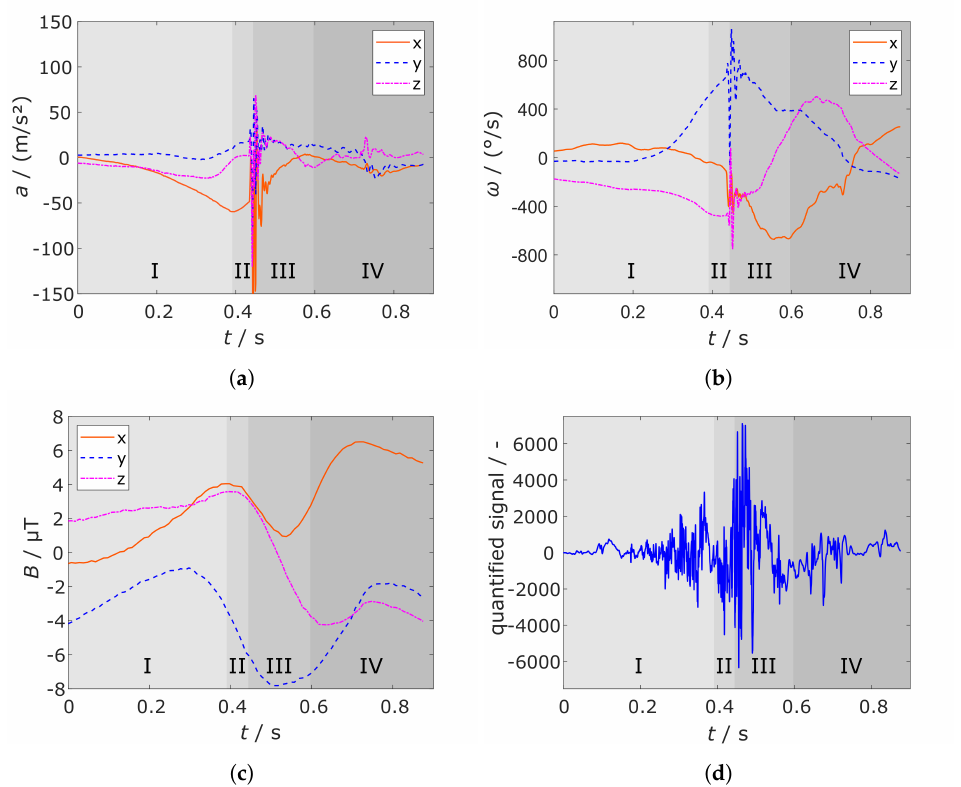
Figure 6. Visualisation of the 10 sensor signals of a forehand topspin with annotated sequences as mentioned in Section 1.2: ( a ) x , y , z component of the accelerometer, ( b ) x , y , z component of the gyroscope, ( c ) x , y , z component of the magnetometer, and ( d ) quantified audio